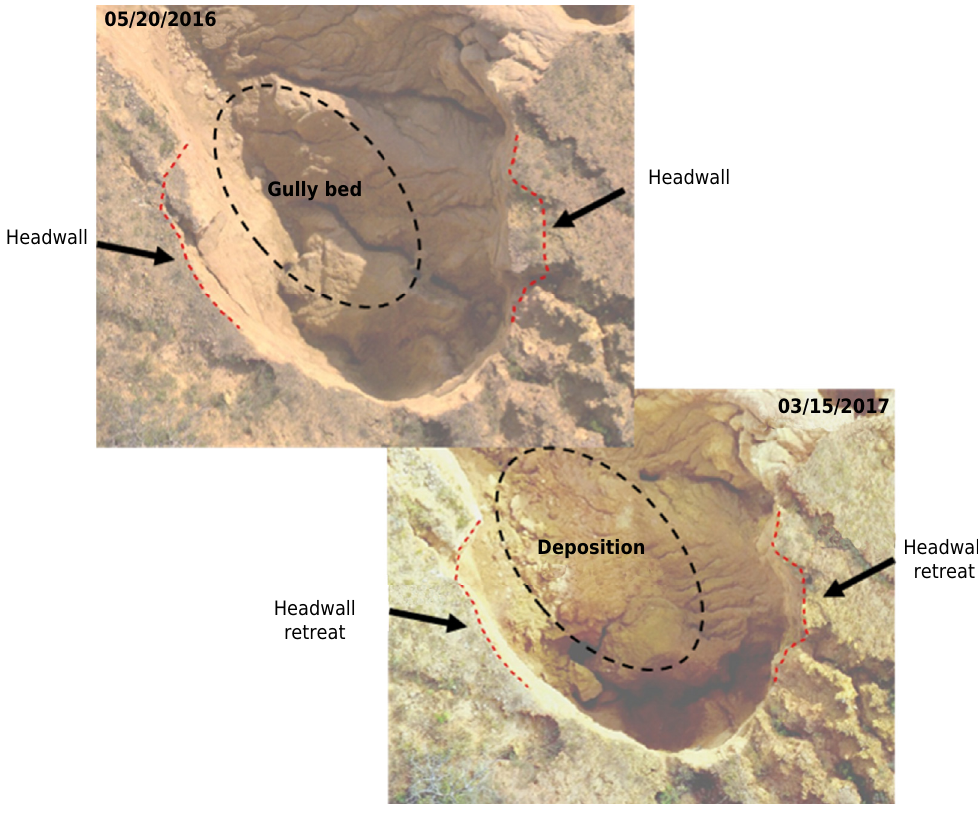
Figure 5. Mass displacement erosion during the studied period between DEM_3 and